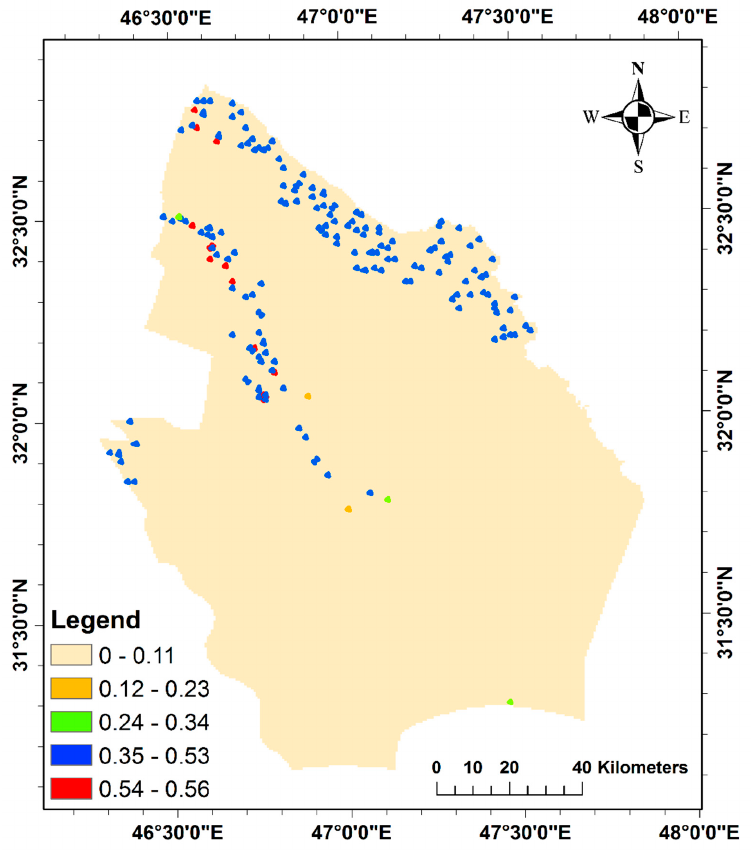
Figure 12. RWH map using Fuzzy Gamma overlay. ISPRS Int. J. Geo-Inf. 2020 , 9 , x FOR PEER REVIEW